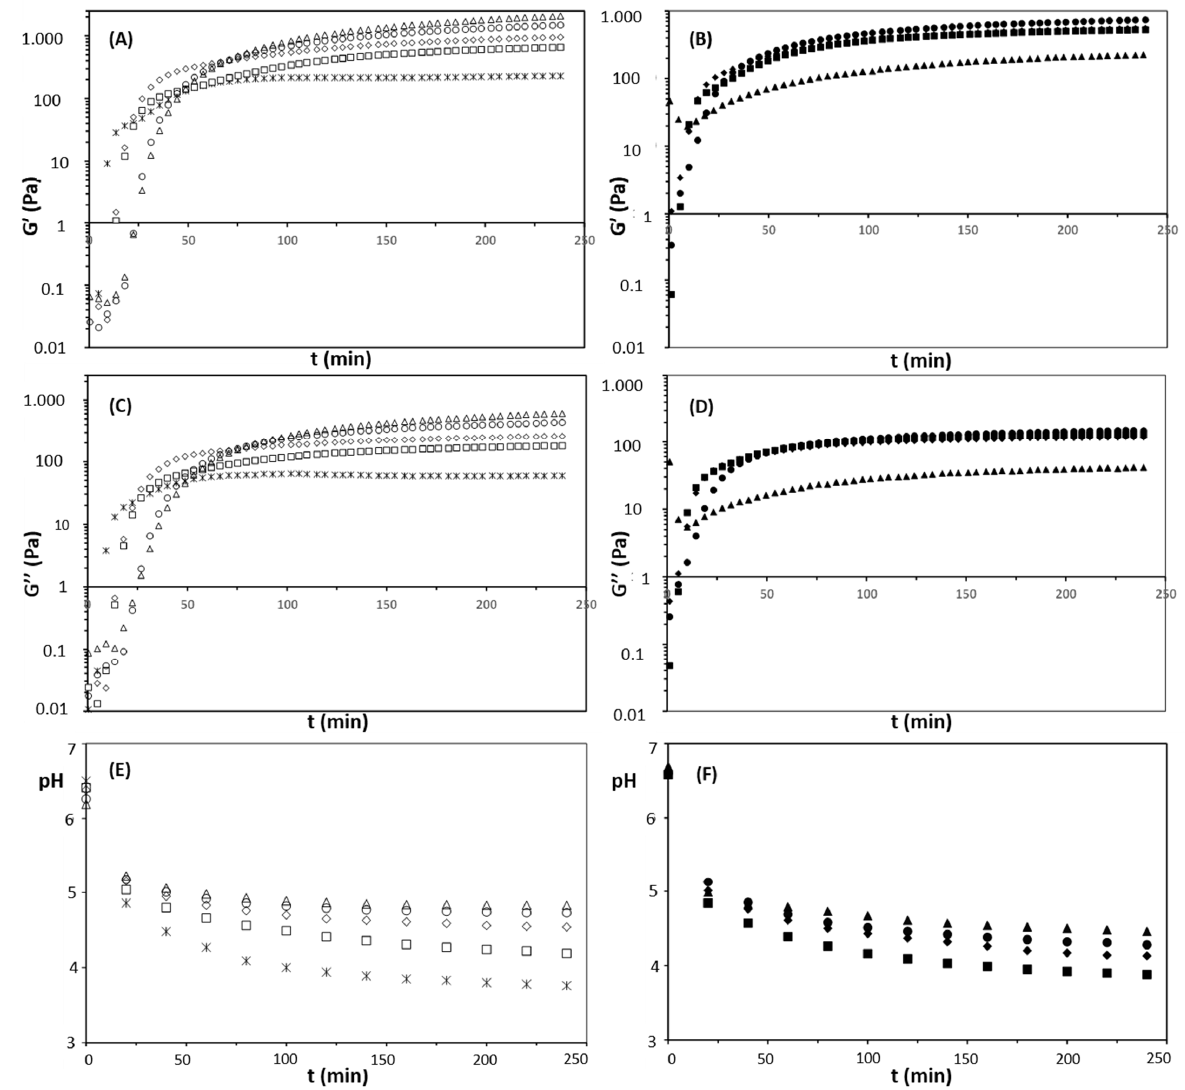
Figure 7. Evolution of elastic (G ′ ) ( A , B ) and viscous shear moduli (G ″ ) ( C , D ), and pH ( E , F ) as a function of acidification time (t) for milk (open symbols) and mixed suspensions (closed symbols). The square, diamond, circle, and triangle markers represent 5, 7, 9, and 11% ( w / w ) protein, respectively. The control milk sample is represented by the “x” symbol.